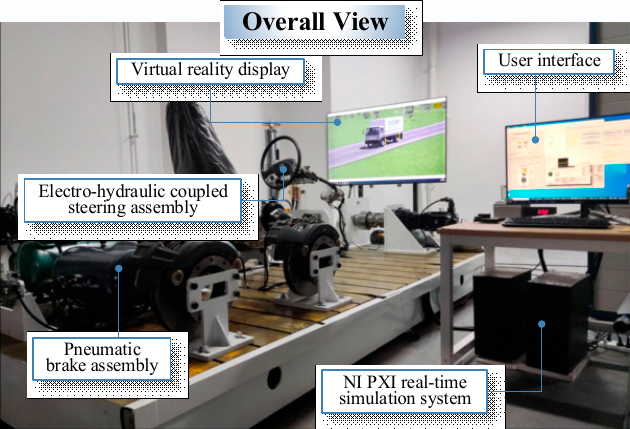
Figure 5. Simulation system based on fuzzy LQ theory.